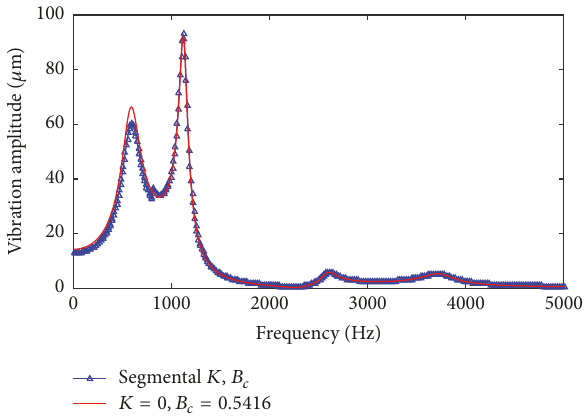
Figure 10: Harmonic response of feedback rod end part with ferrofluid.